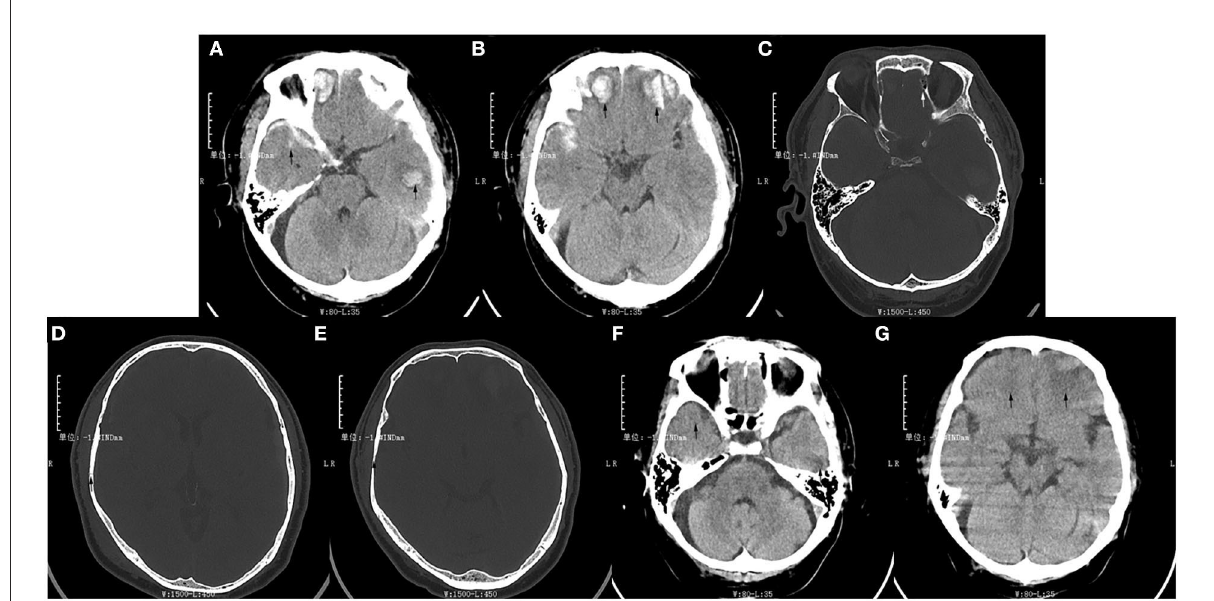
FIGURE1 The patient’s brain computed tomography results of the first hospitalization after trauma. (A,B) Two pieces of high-density signal were, respectively, in the bilateral temporal lobe and frontal lobe at the time of admission (arrows). (C) The continuity of the left orbital bone was interrupted (arrow). (D,E) The continuity of the right cranial parietal bone and temporal bone were interrupted (arrows). (F,G) The signal of lesion area displayed low-density in the bilateral temporal lobe and frontal lobe at the time of discharge